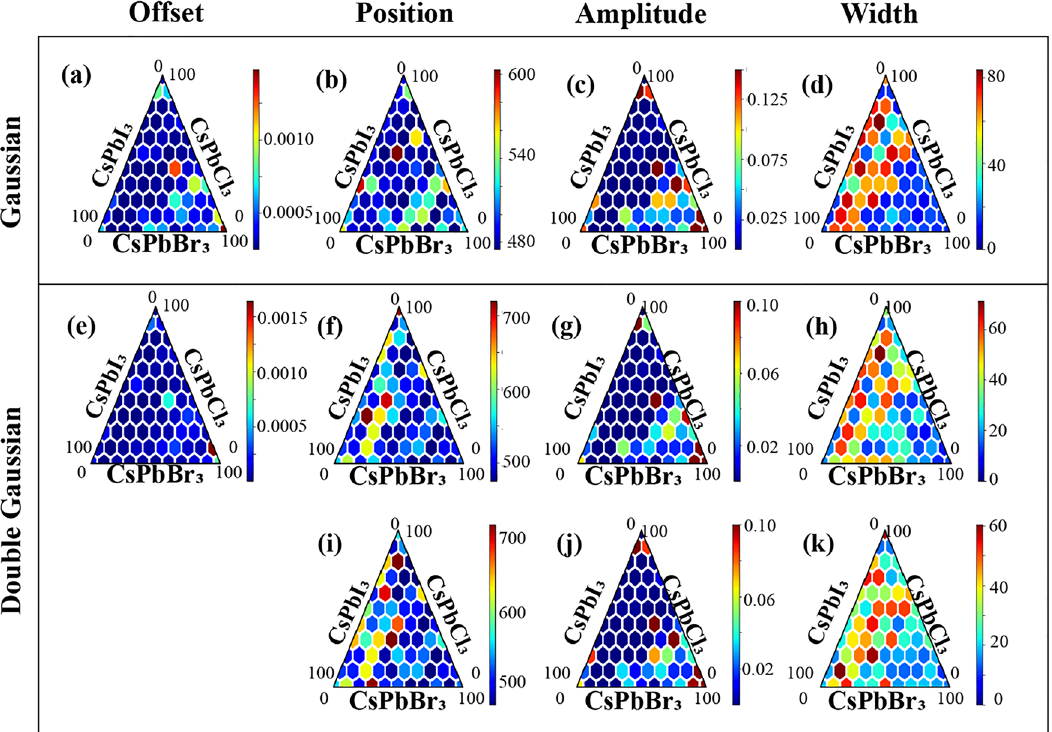
Figure 7: Shown is the Bayesian fit parameters, specifically the offset, peak positions, amplitudes, and widths, for the (a – d) Gaussian and (e – k) Double Gaussian, models. The parameters for the Lorentzian, Double Lorentzian, and Lorentzian Gaussian model are shown in Figure